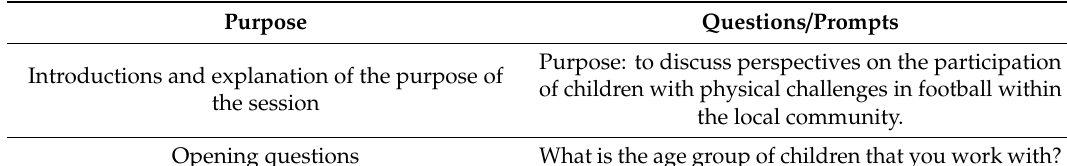
Table A1. Clinician focus group schedule.